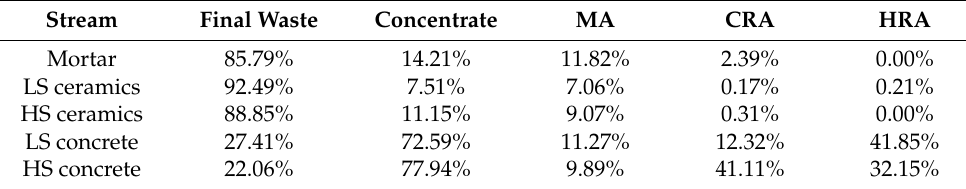
Table 6. Distribution of aggregates (in relation to the feed) over the streams.